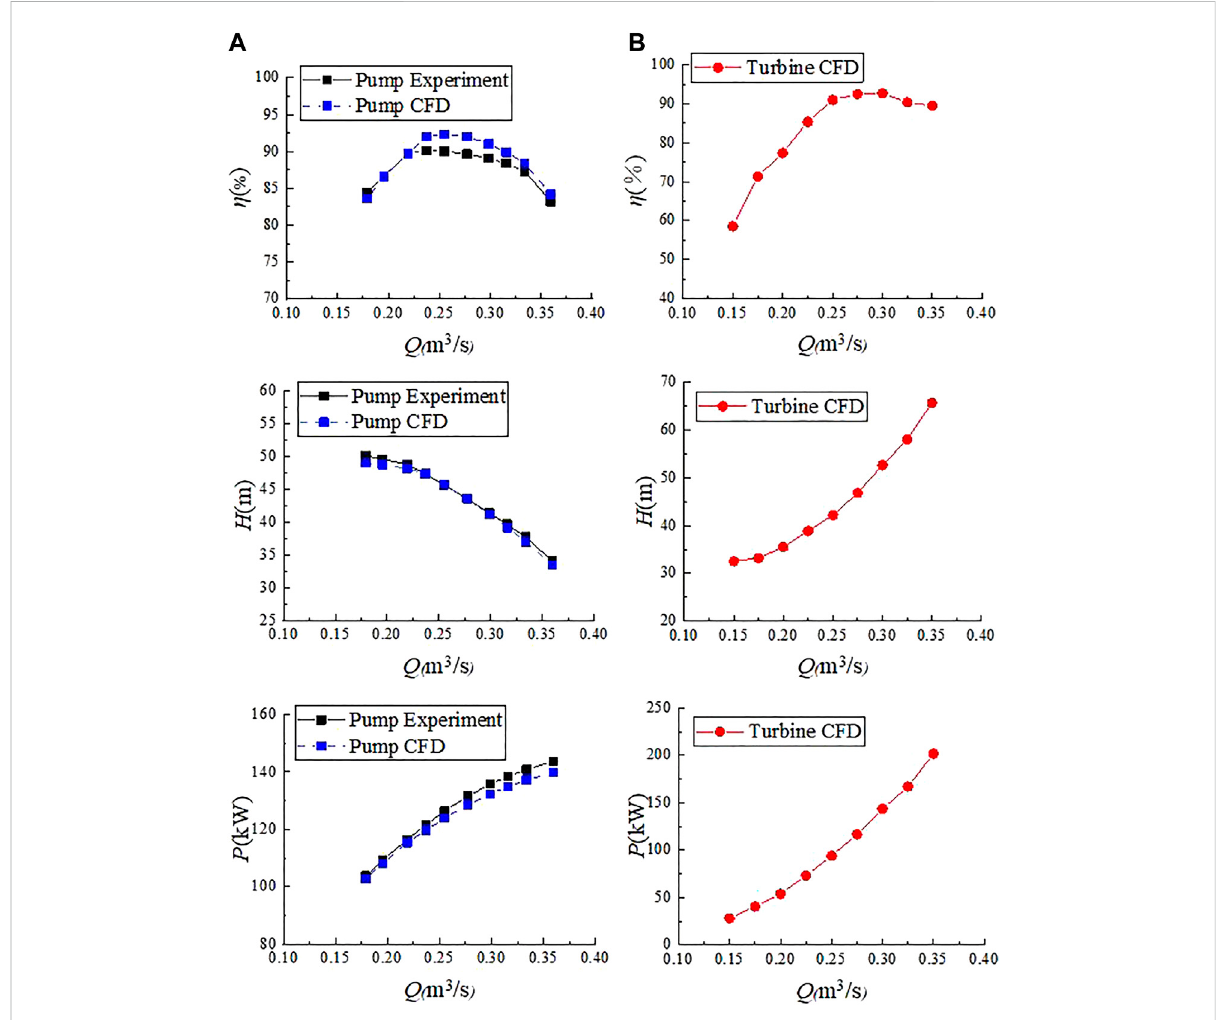
FIGURE 5 Performance characteristic curve Pump (A) /Turbine (B)